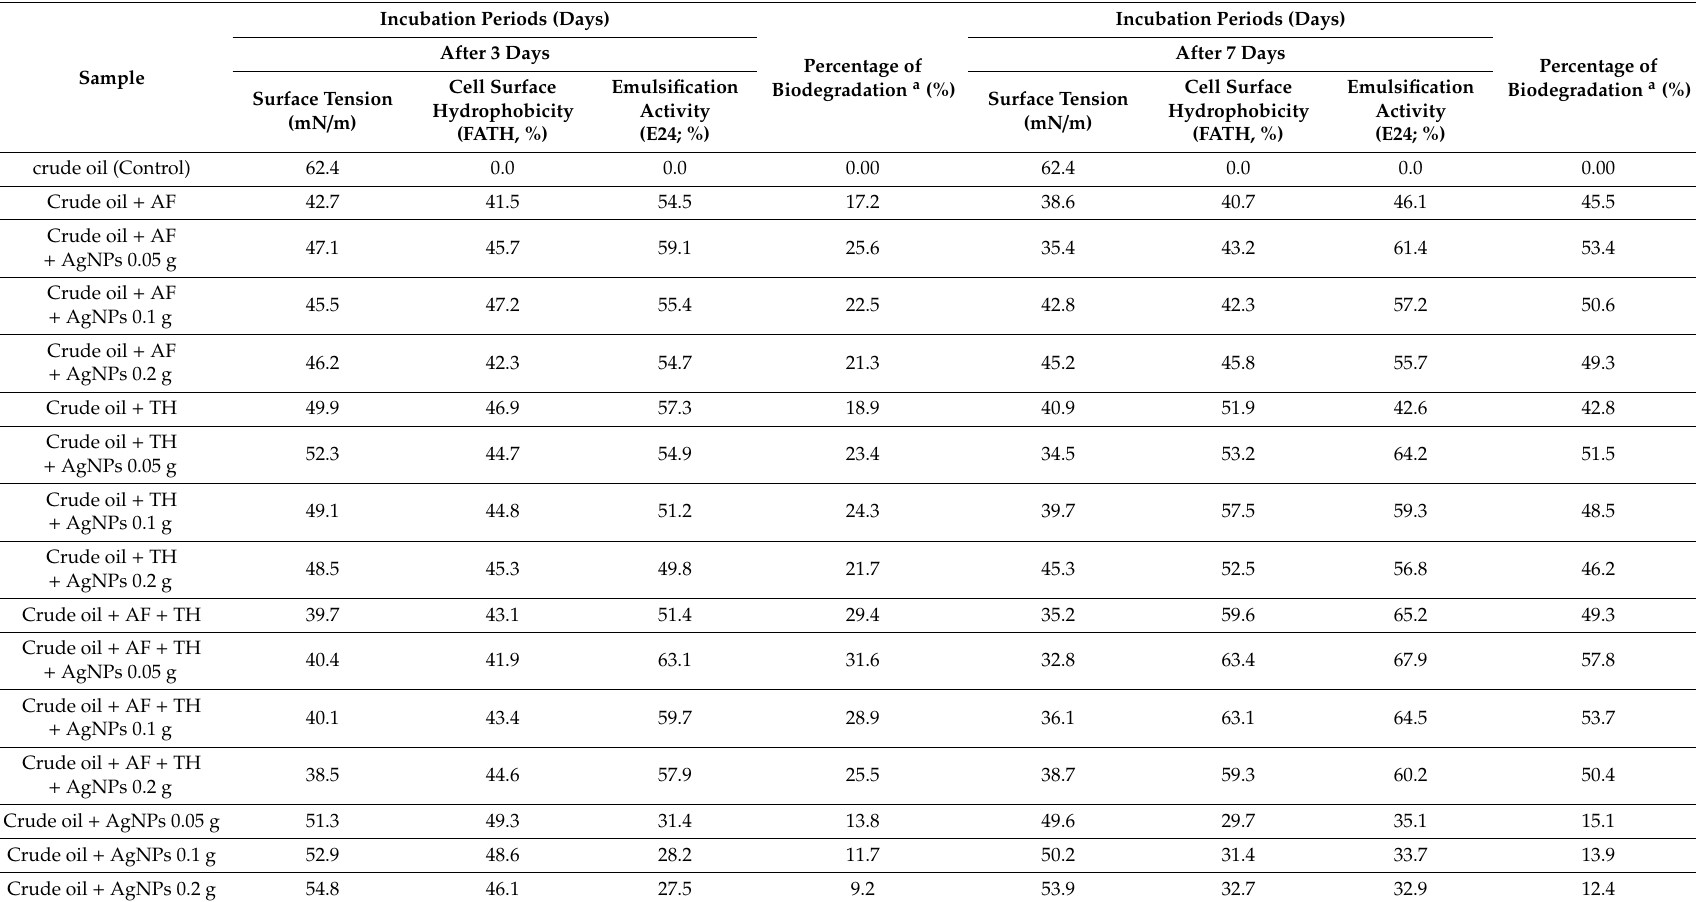
Table 4. Percentage of bioremediation some physicochemical properties of crude oil after treatment with A. flavus AF15 or / and T. harzianum TH07 using di ff erent concentrations of